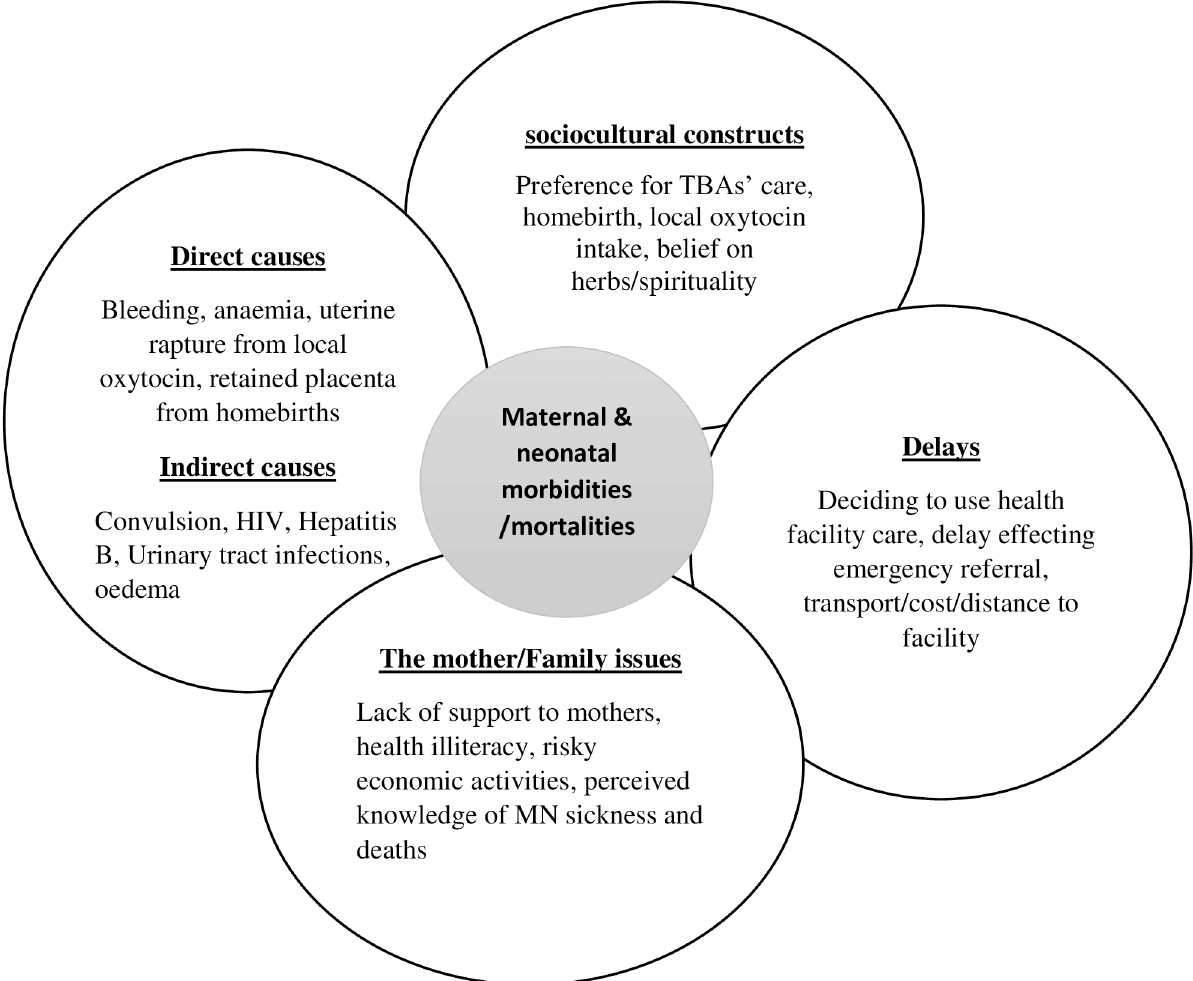
Fig 1. Interrelationships among the causes of poor pregnancy and birth outcomes.